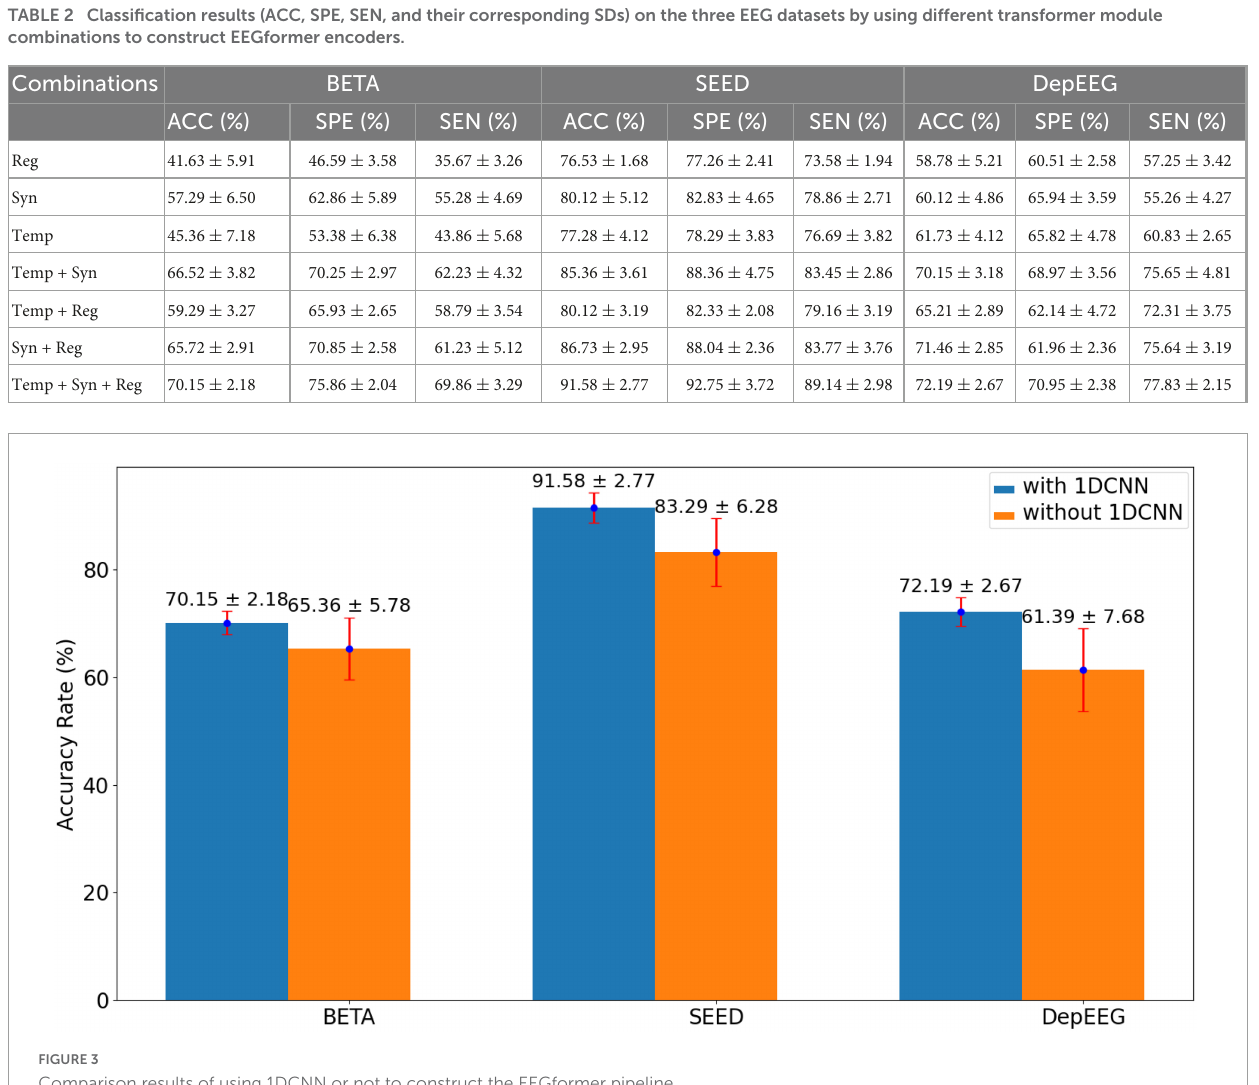
FIGURE3 Comparison results of using 1DCNN or not to construct the EEGformer pipeline.